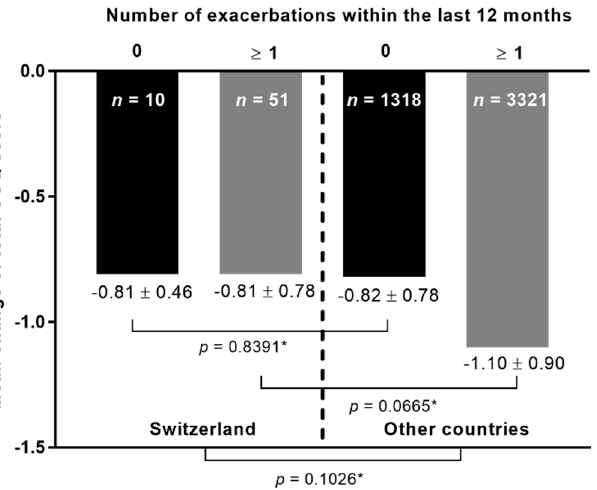
Figure 2. The mean change in the total CCQ score at visit 2 according to number of exacerbations within the last 12 months before study inclusion. n : number of patients. * Kruskal–Wallis test.